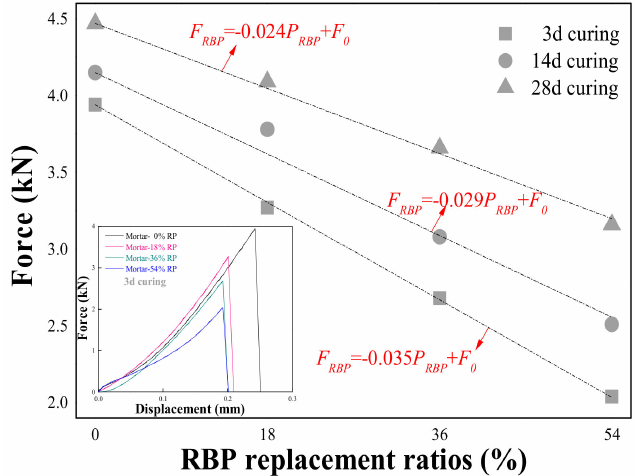
Figure 9. Flexural strength of mortar containing RBP after various curing days. (Displayed values are the mean values of three